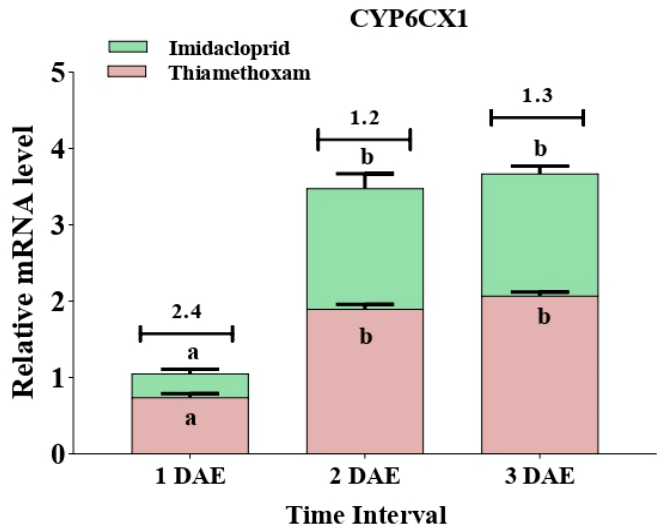
Figure 8. Expression of the insecticide-resistant gene ( CYP6CX1 ) in whiteflies after exposure to sublethal doses of imidacloprid 17.8 SL and thiamethoxam 25 WG at various durations (1 DAE, 2 DAE, and 3 DAE). Bars represent the standard error of the mean (SEM), and the different letters above the symbols indicate a significant difference at 0.05 level. DAE: days after exposure.